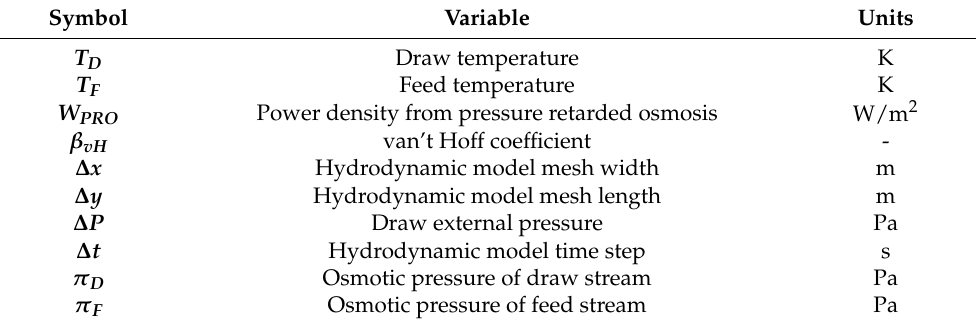
Table 1. Cont. Symbol Variable Units T D Draw temperature K T F Feed temperature K W PRO Power density from pressure retarded osmosis W/m 2 β vH van’t Hoff coefficient - ∆ x Hydrodynamic model mesh width m ∆ y Hydrodynamic model mesh length m ∆ P Draw external pressure Pa ∆ t Hydrodynamic model time step s π D Osmotic pressure of draw stream Pa π F Osmotic pressure of feed stream